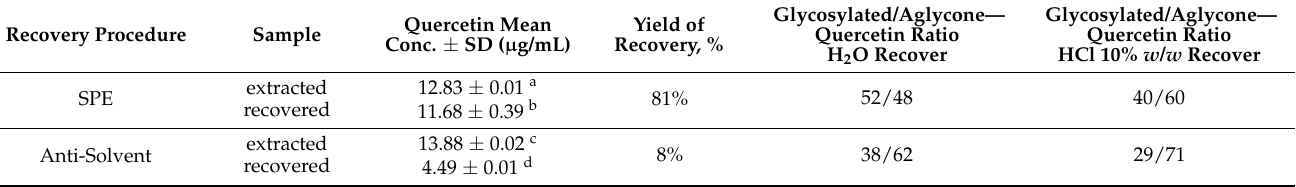
Table 2. Recovery of quercetin from the extracted samples evaluation via HPLC